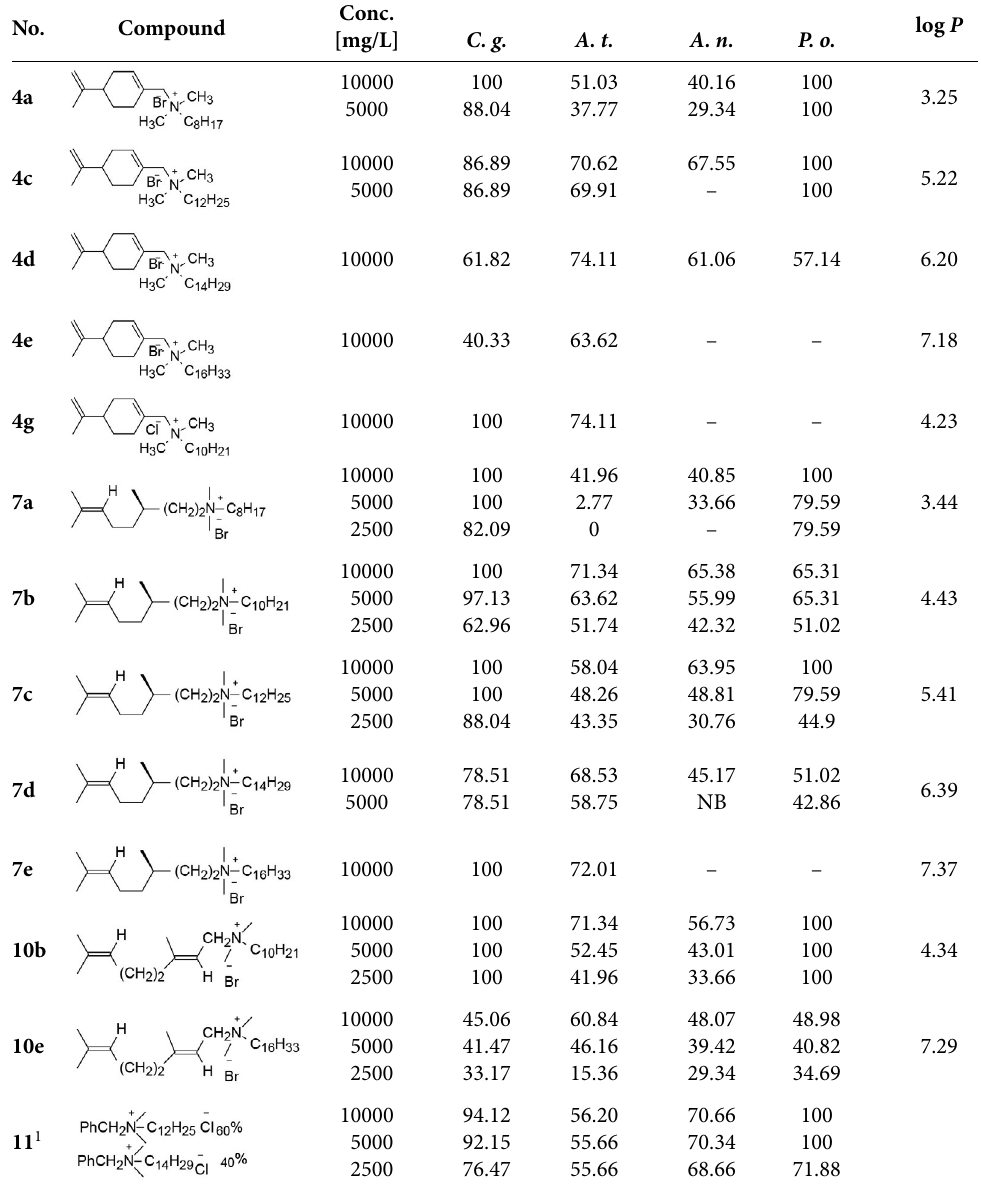
Table 2. Efficacy of test compounds 4a – h , 7a – e and 10a – e [%] against fungi destroying wood and technical materials